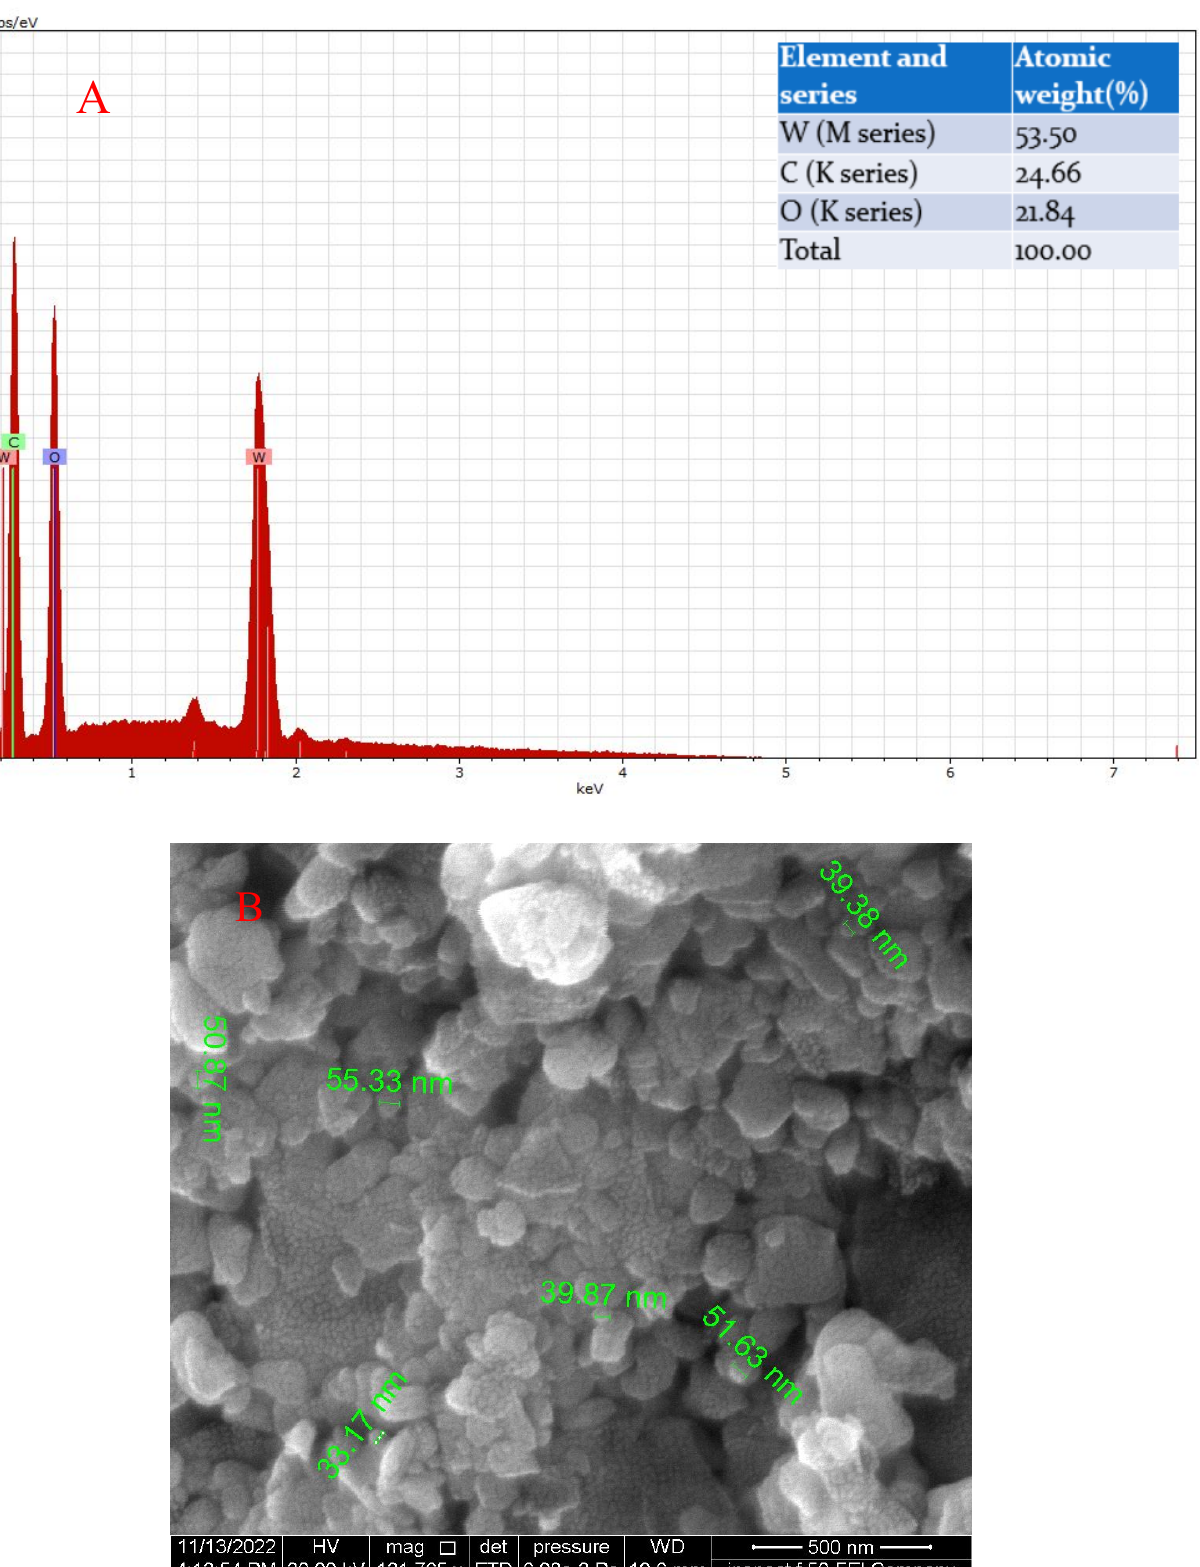
Figure 5. ( A ) The EDX of GO-WO 2.89 nanoparticles and ( B ) the SEM analysis of composite GO-WO 2.89.